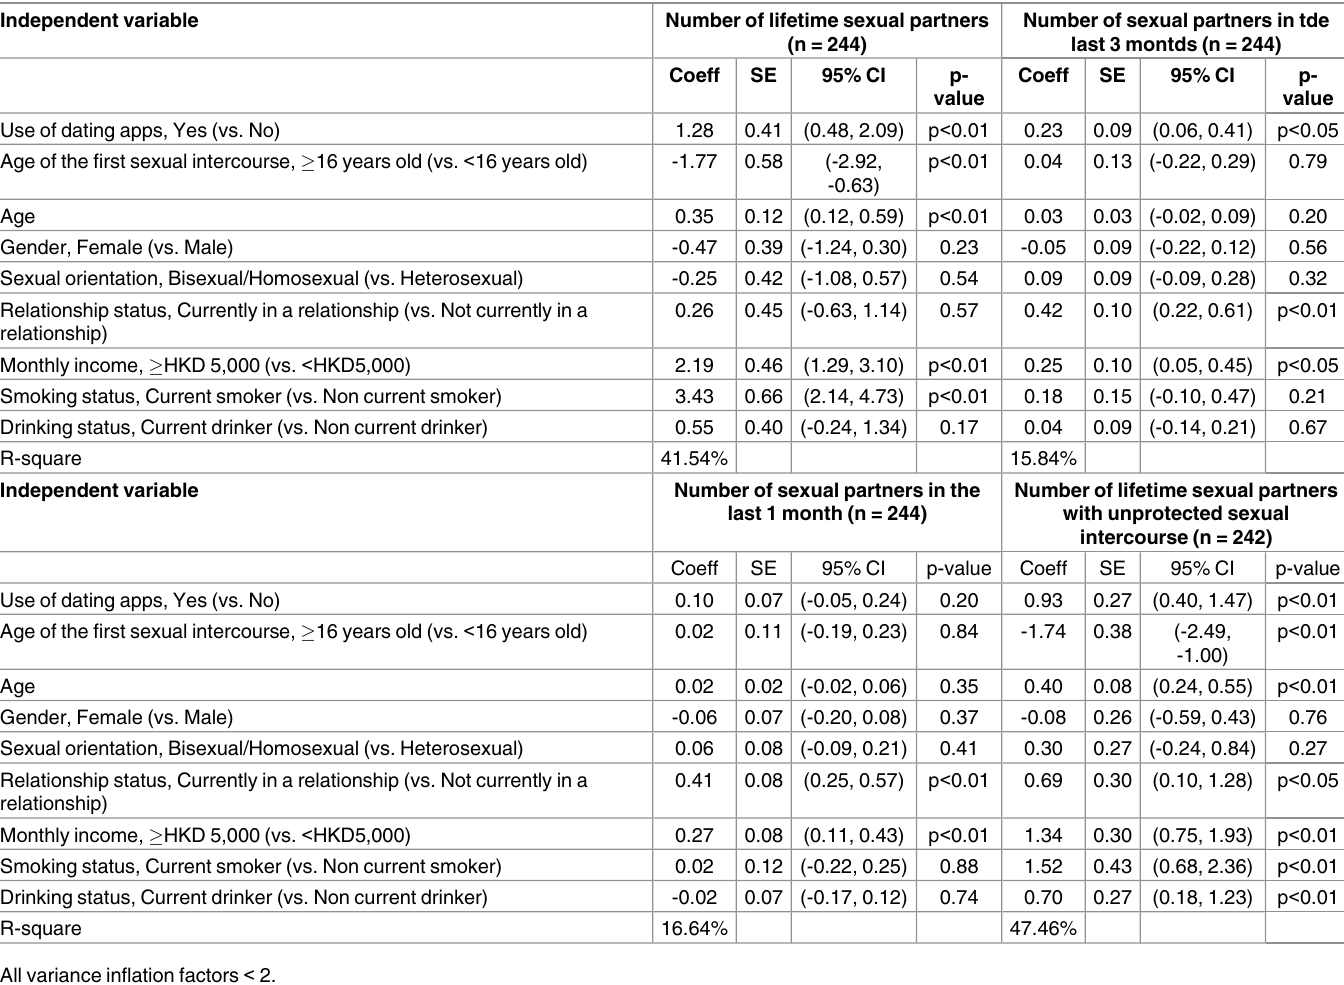
Table 4. Factors associated with the number of sexual partners by multiple linear